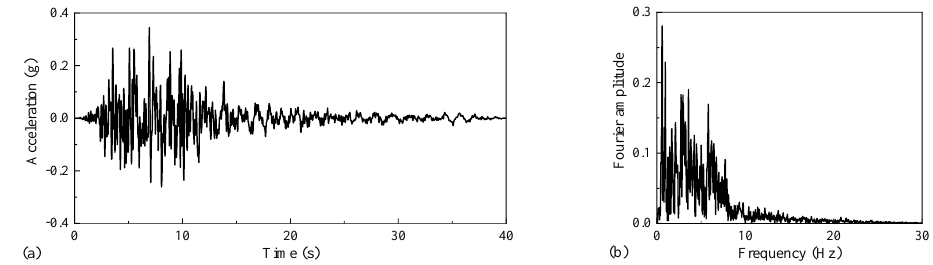
Figure 11. Kobe seismic wave ( a ) acceleration − time curve and ( b ) spectrum. Figure 12 is a schematic diagram of the internal force of the lining; N , τ and M c represent the axial force, shear force and bending moment of the lining in the cross section, T represents the longitudinal axial force of the lining. M v and M h represent the vertical and horizontal bending of the lining in the horizontal plane moment.